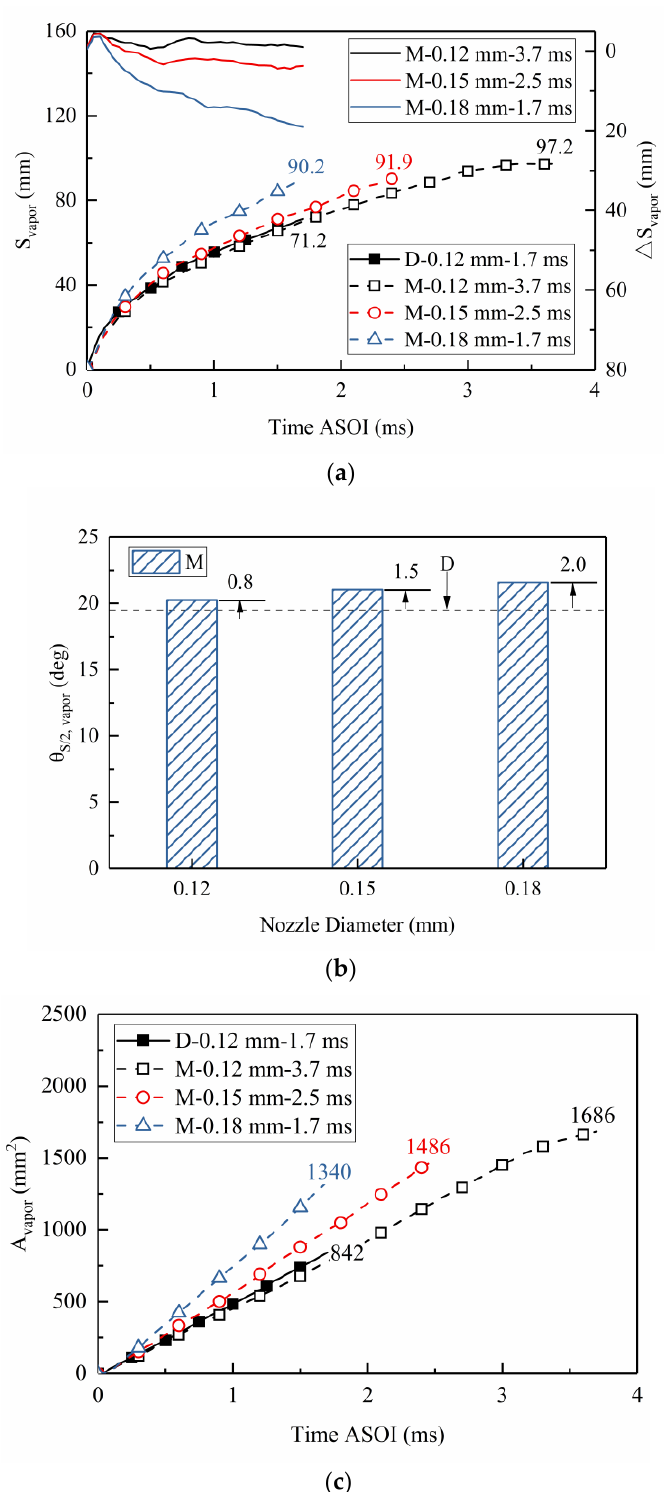
Figure 11. Quantitative analysis of vapor phase spray under different strategies. ( a ) Spray tip penetration results. ( b ) Spray angle results. ( c ) Spray area results.